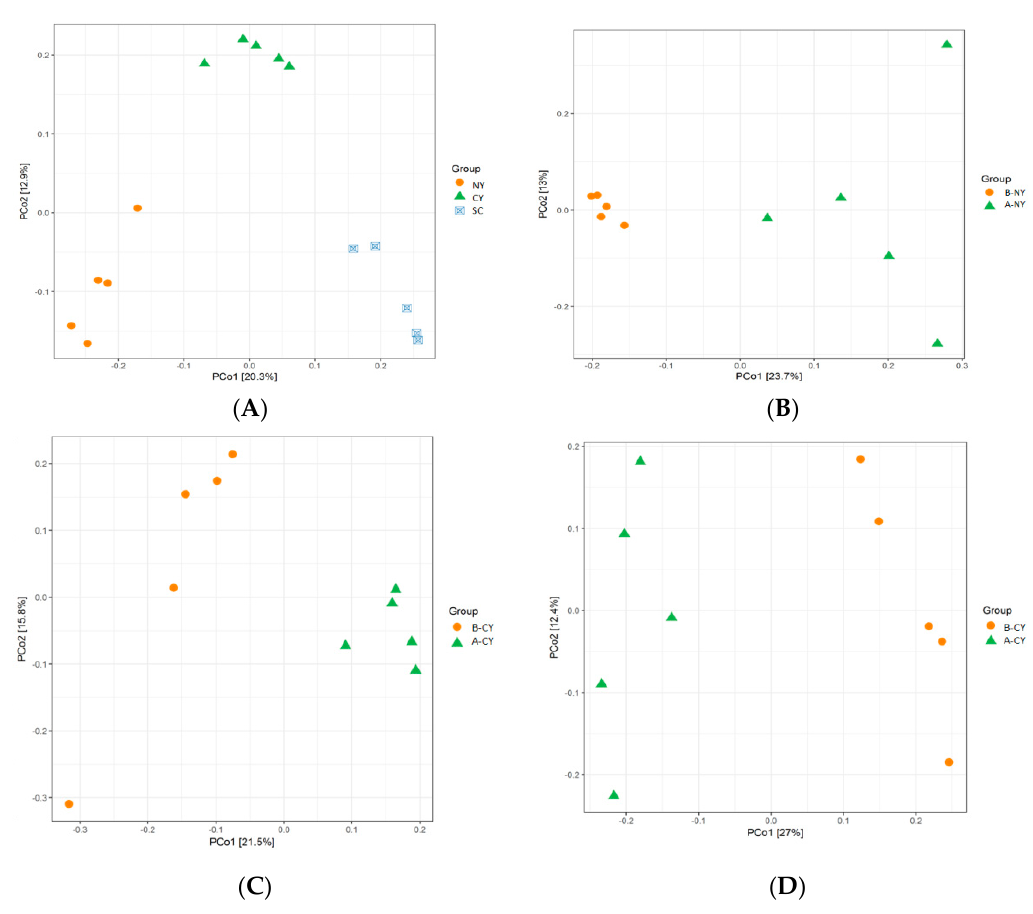
Figure 1. Principal Coordinate Analysis (PCoA) of rumen bacterial community structures of cattle in NY, SC and CY groups before ( A ), rumen bacterial community before and after transportation in NY ( B ), rumen bacterial community before and after transportation in SC ( C ), rumen bacterial community before and after transportation in CY ( D ). The PCoA plots were constructed using the weighted UniFrac method.